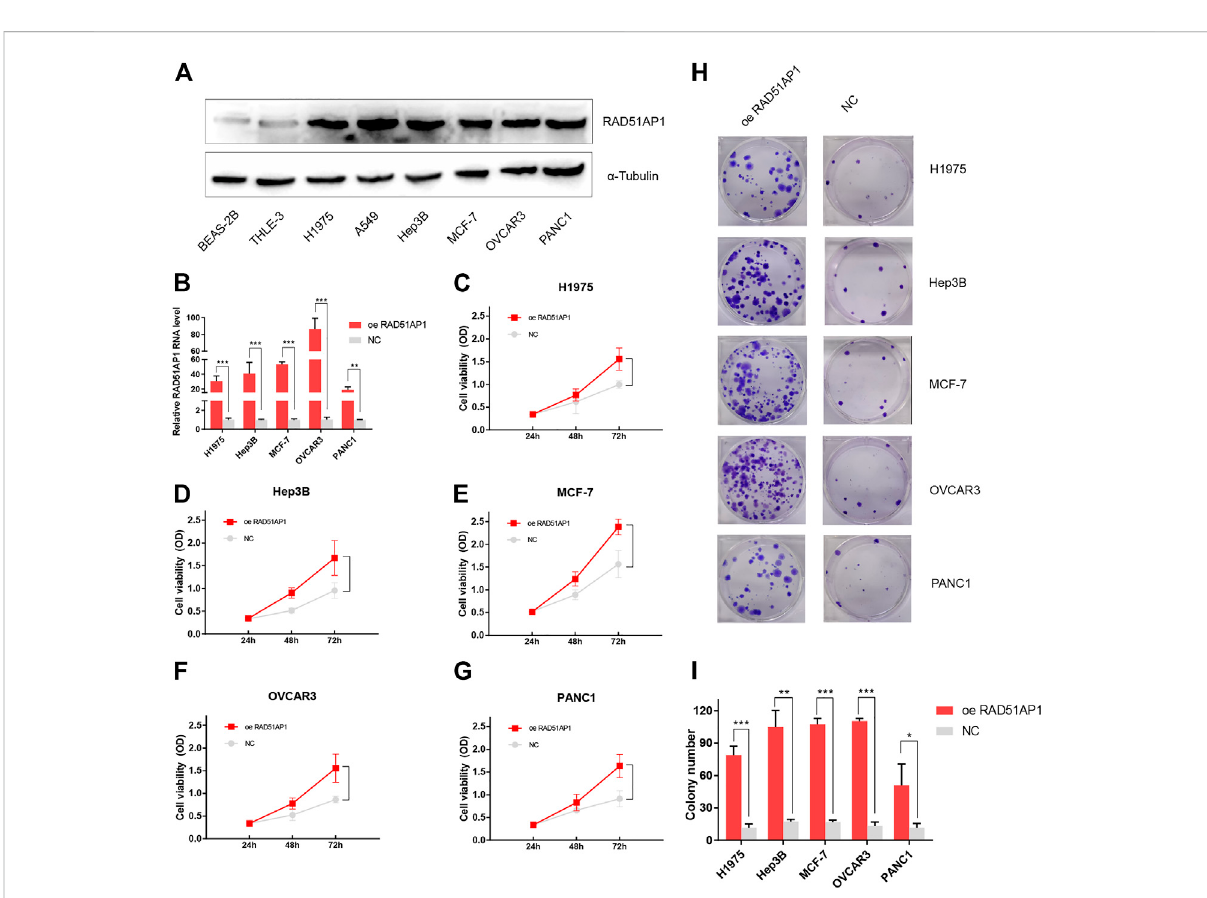
FIGURE 12 Validation of the oncogenic role of RAD51AP1 by vitro experiment. The protein expression level of RAD51AP1 in each cell line was tested by westernblot.RAD51AP1wasup-regulatedinvariouscancercells,includingH1975,A549,Hep3B,MCF-7,OVCAR3,andPANC1,comparedtonormal cellsBEAS-2BandTHLE-3 (A) .Then,weselectedH1975,Hep3B,MCF-7,OVCAR3,andPANC1torepresenteachtypeofcancerforfurthervalidation. After successfully transfecting vector or RAD51AP1 OE plasmids in each cancer cell line, veri fi ed via qPCR (B) , we performed CCK8 and colony formation assays. Results showed that RAD51AP1 signi fi cantly enhanced cancer cells viability (C – G) and promoted cancer cells proliferation (H,I)